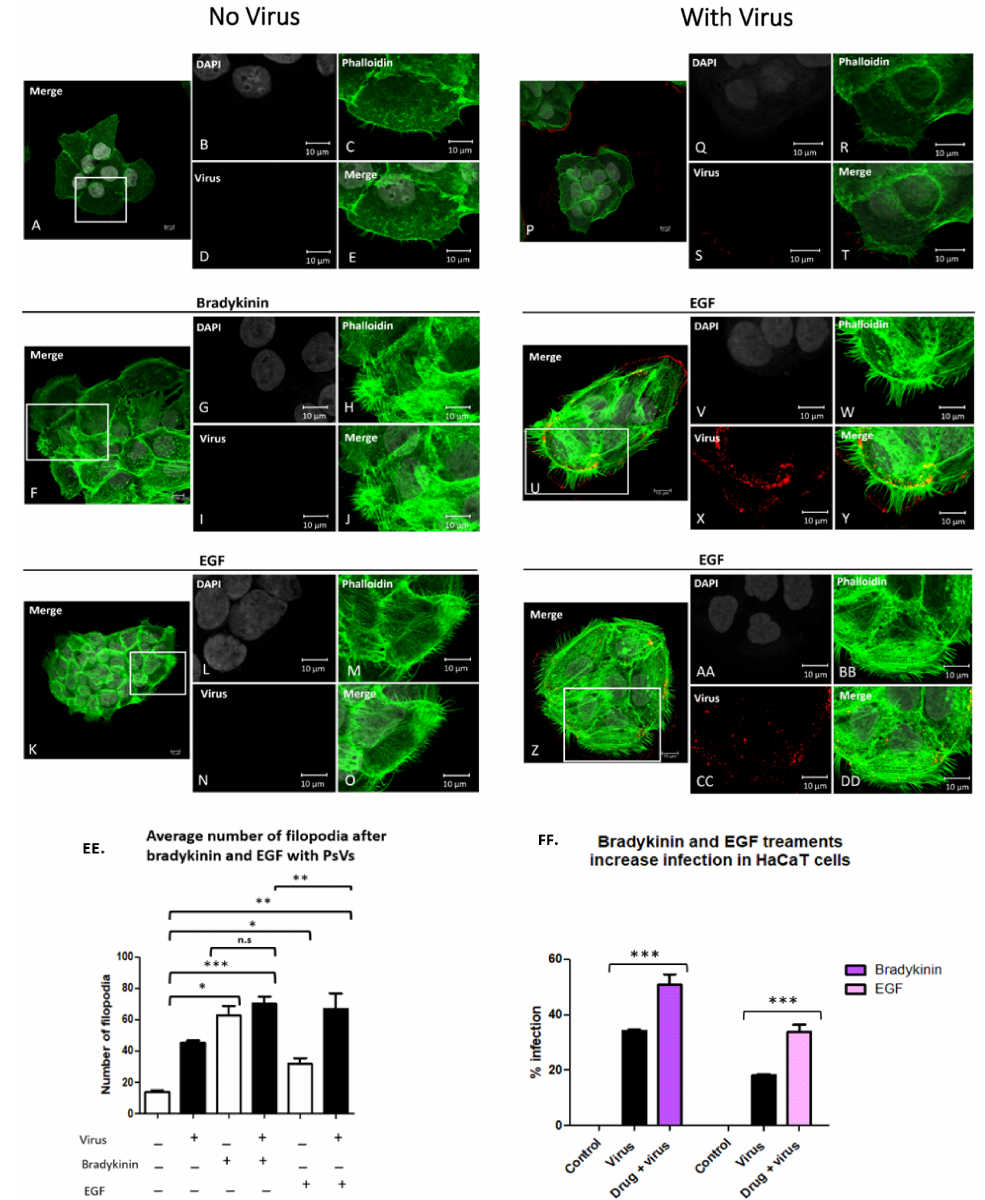
Figure 2. Bradykinin and EGF treatments increase the average number of filopodia in HaCaT cells and increase infection. HaCaT cells were seeded onto coverslips and treated with 200 ng/mL bradykinin, 200 ng/mL EGF, plus virus for 15 min. Confocal microscopy images of control cells ( A – E ), and cells treated with bradykinin ( F – J ) or EGF ( K – O ) without virus. Cells incubated with virus alone ( P – T ) or with virus and bradykinin ( U – Y ) or EGF ( Z – DD ). Nuclei stained with DAPI (grey), filopodia visualized with phalloidin (green), and L1 capsid stained with H16.V5 antibody (red). All channels were merged ( E , J , O , T , Y , DD ). Graph representation of average filopodia numbers for control cells and cells treated with virus, bradykinin, EGF, or drug with virus ( EE ). Filopodia were counted using LAS X Life Science Microscope Software Platform. Statistical significance was determined by ANOVA Dunnett’s multiple comparison test ( n = 45, *, p < 0.05, **, p < 0.01, ***, p < 0.001). Percent infection with or without drug treatment was measured with flow cytometry ( FF ). Flow cytometry data of infection in HaCaT cells with or without bradykinin and EGF. Data was taken from three individual experiments in triplicate. Statistical differences determined by ANOVA Dunnett’s multiple comparison test, (samples compared to control infection, n = 9, *** p < 0.001). Average was displayed with